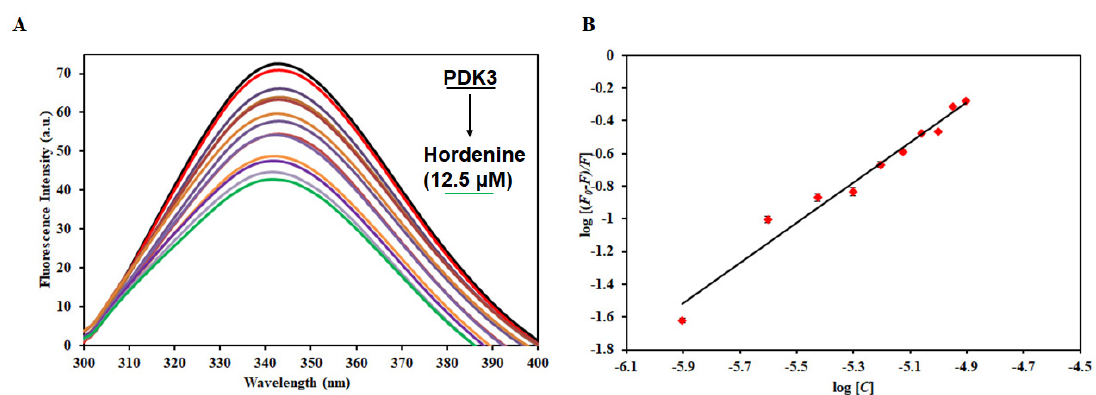
Figure 4. Binding studies of hordenine with PDK3. ( A ) Fluorescence emission spectra of PDK3 (4 µM) with the increasing concentration of hordenine (0–12.5 µM). ( B ) Modified Stern−Volmer plot obtained from the quenching of PDK3 fluorescence with increasing concentration of hordenine.